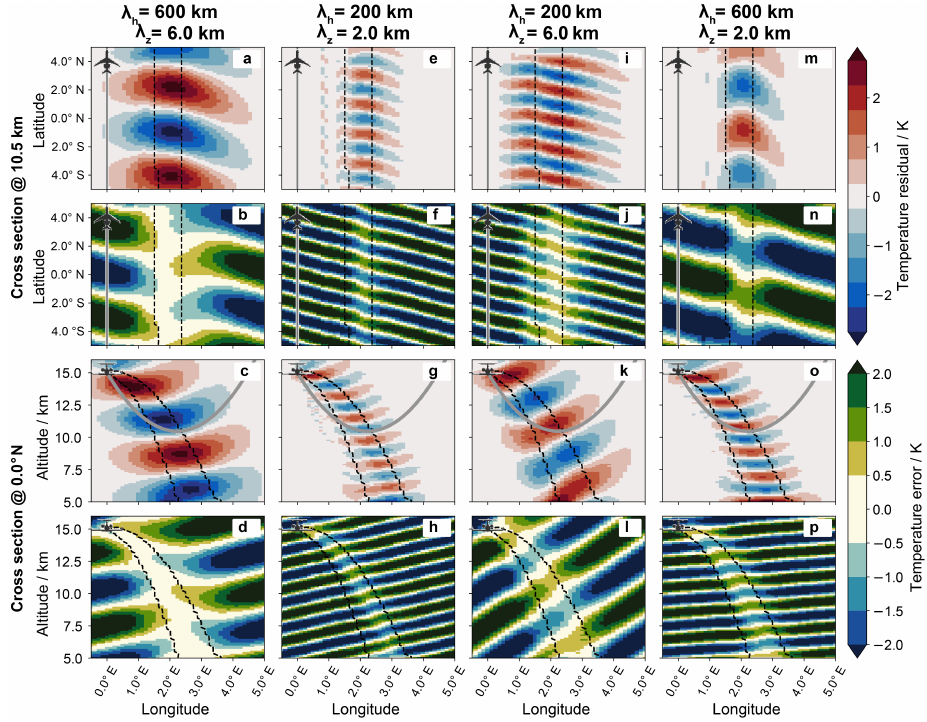
Figure 9. Cross sections of retrieved waves (first and third rows) and differences between synthetic and retrieved waves (second and forth rows) of the LAT retrieval. The different columns show waves with different horizontal ( λ h ) and vertical ( λ z ) wavelengths. The synthetic horizontal wave orientation of all waves is ϕ s = 30 ◦ and thus these waves are tilted away from the aircraft.